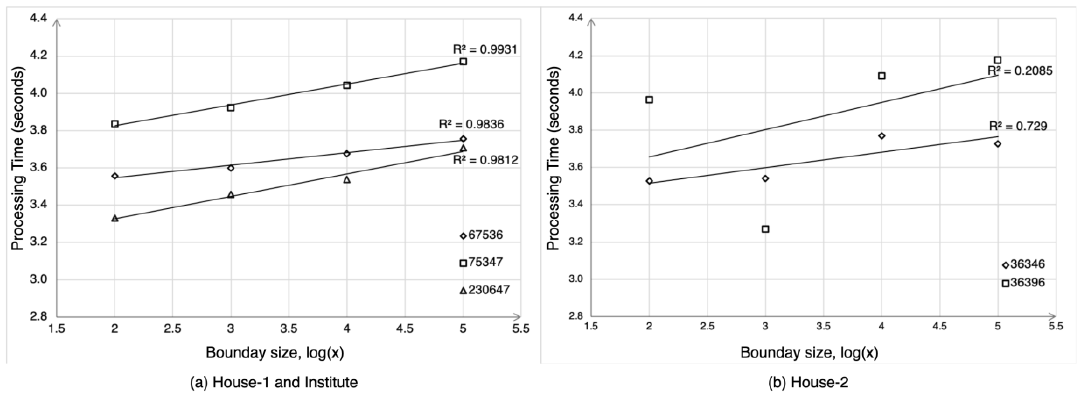
Figure 12. Linear regression analysis for ( a ) House-1 and Institute, and ( b ) House-2.